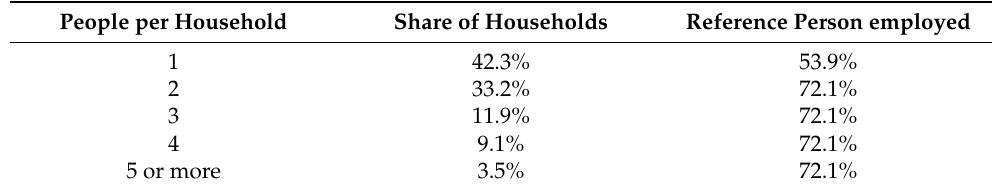
Table 1. Composition of Households in Germany in 2019 [27,28]. People per Household